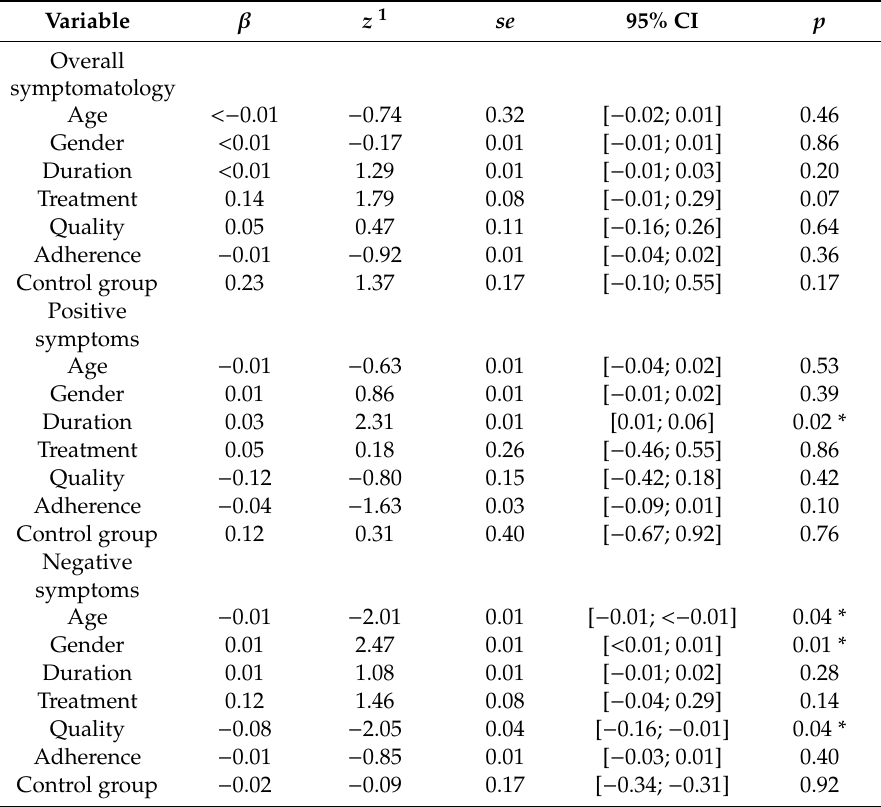
Table 1. Analysis of moderating variables (meta-regression).